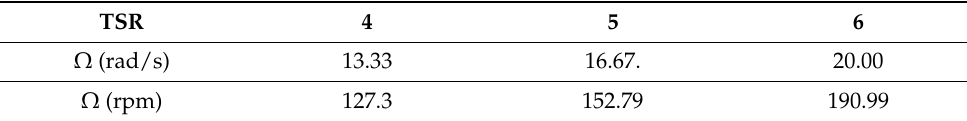
Table 1. Rotation Speed of different